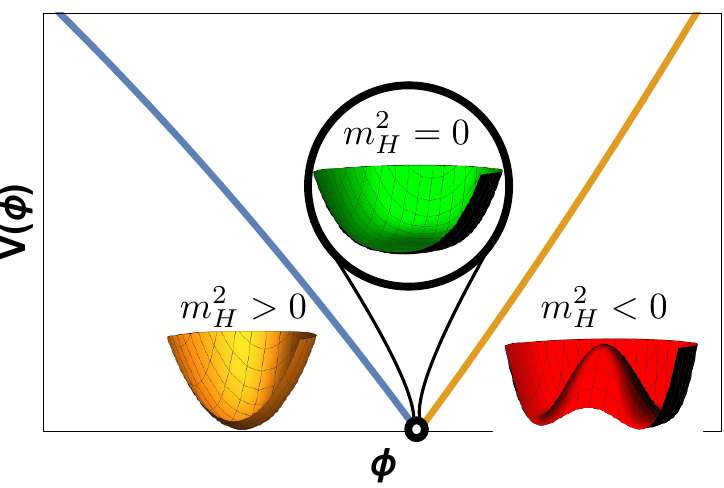
Figure 1. This (cid:12)gure exhibits a cartoon of a potential for a modulus (cid:12)eld, (cid:30) , where the singular minimum matches on to a critical point at which the mass of a physical light Higgs (cid:12)eld (cid:13)uctuation passes through zero. On either side of the singular point, the Higgs boson mass is (cid:12)nite and positive, but on one side the mass squared for the (cid:12)eld is negative, with the instability driving spontaneous symmetry